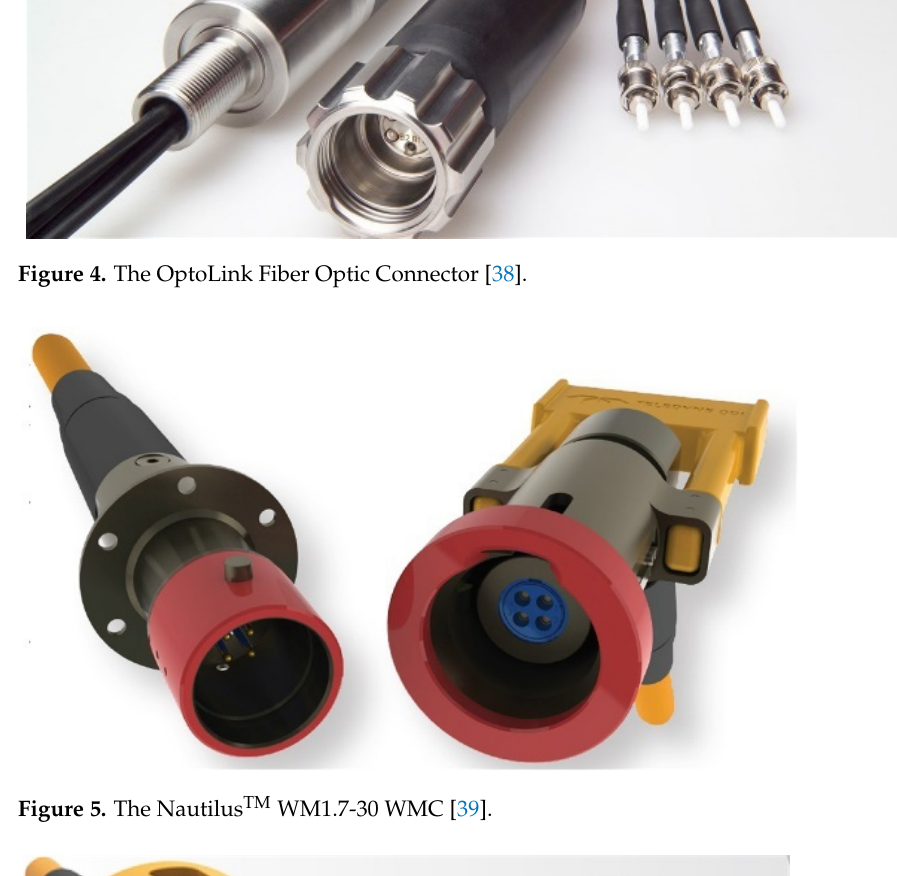
Figure 4. The OptoLink Fiber Optic Connector [38].